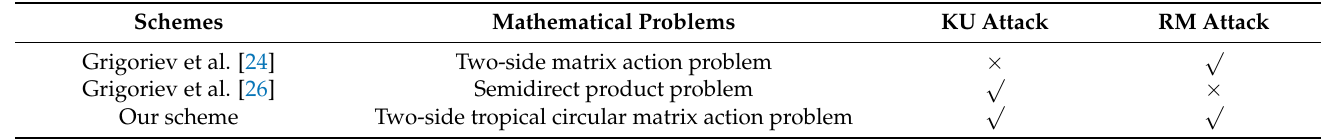
Table 1. Comparison among relevant tropical schemes.